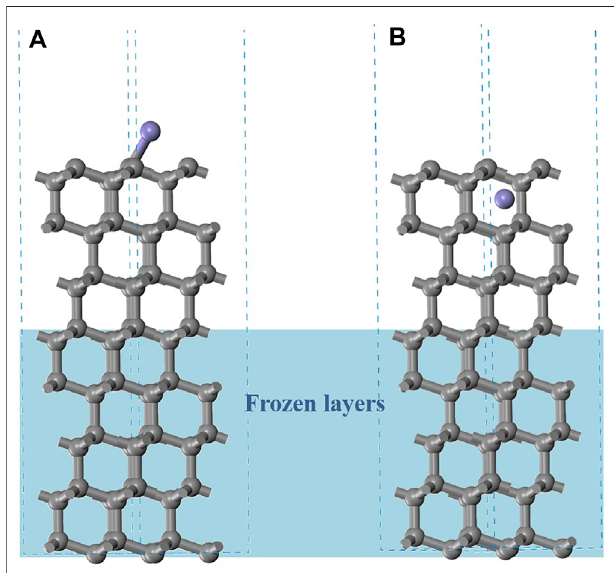
FIGURE 6 | The initial structures of diamond (111) surface with different Fe diffusion locations (purple marked Fe atom position). (A) Fe binding on diamond (111) surface, (B) Fe inserted into diamond.